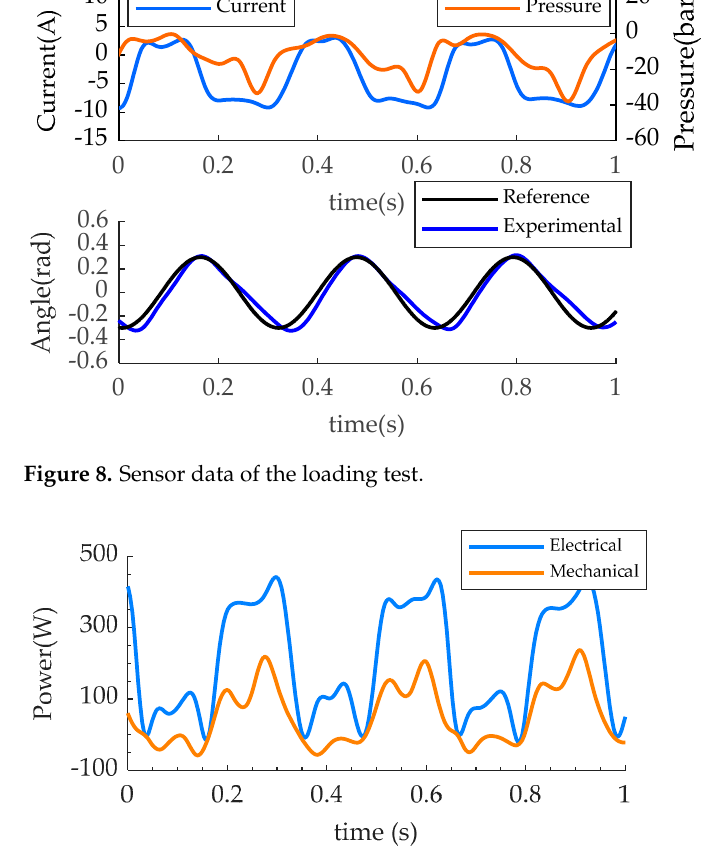
Figure 9. Mechanical power and electrical power of the loading test.